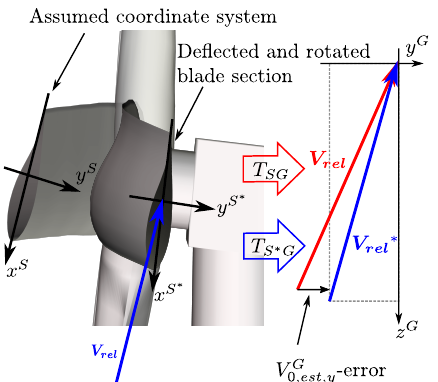
Figure 13. The torsion angle of the deflected blade section is un- known in the current method. An error is thereby introduced when mapping the relative velocity, V rel , from the blade-section to the ground coordinates using the transformation matrix, T SG . The re- sult is the overestimation of the y component of the estimated free wind speed, V G . 0 , est ,y